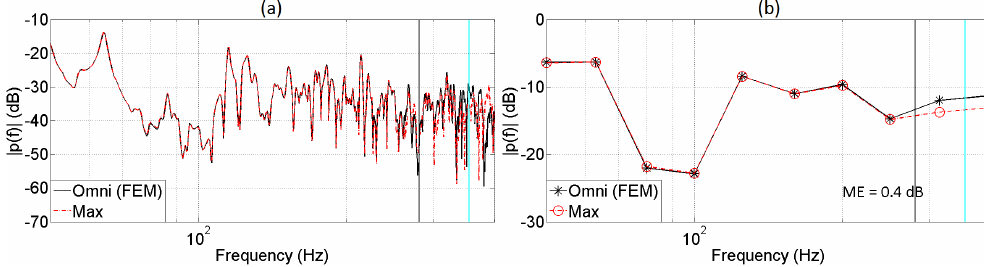
Figure 23. Comparison of full ( a ) and 1/3 octave band ( b ) frequency responses. Translated PWE and omnidirectional room impulse response (FEM) at translated Position 4.